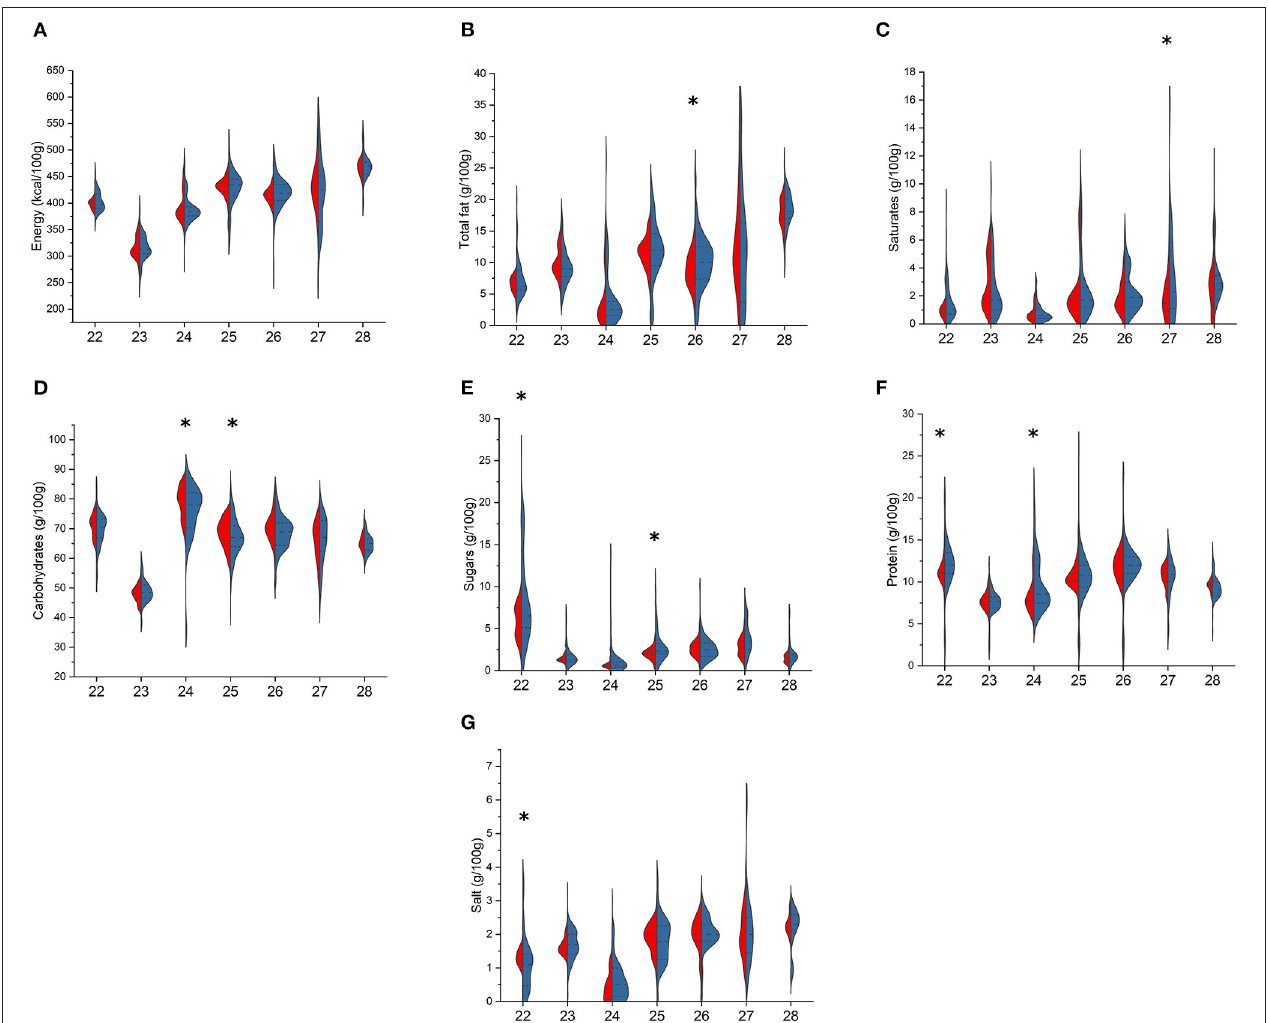
FIGURE 5 | Comparison of energy (A) , total fat (B) , saturates (C) , total carbohydrates (D) , sugars (E) , protein (F) , and salt (G) content in branded (BR, in blue) and private-label (PL, in red) types of bread substitutes. 22: rusks; 23: wraps; 24: rice and corn cakes; 25: crackers; 26: breadsticks; 27: “croutons, bruschetta, and frisella bread”; 28: taralli. For each type, asterisk indicates significant difference between BR and PL items (Mann–Whitney non-parametric test for two independent samples), p <